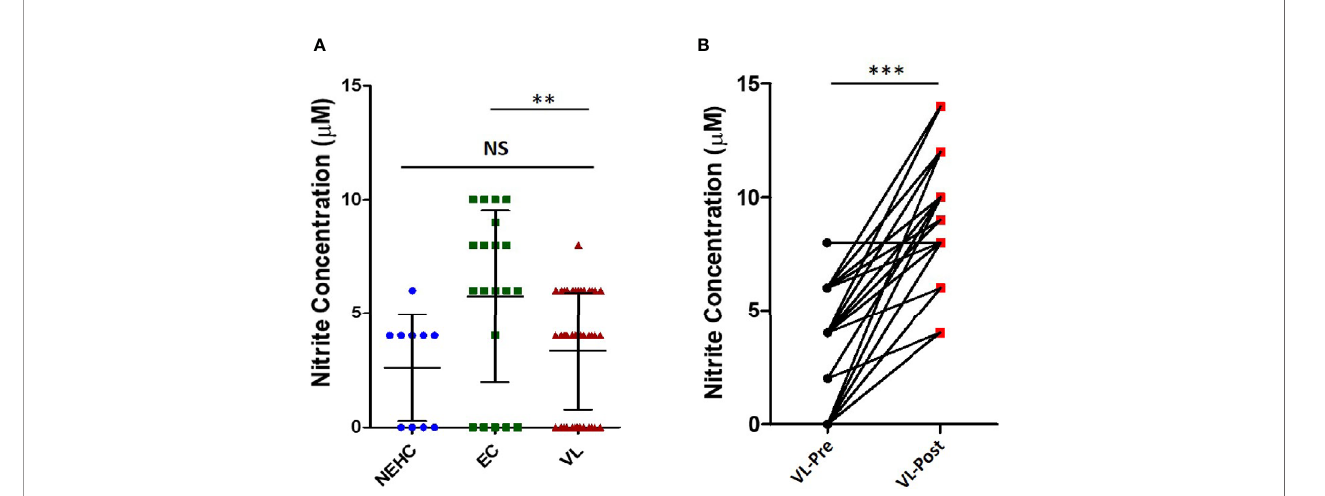
FIGURE 1 | Nitrite levels in the VL plasma show improvement upon treatment. (A) Nitrite concentration in the plasma from VL patients (n=45) (circles), ECs (n=25) (squares), and NEHCs (n=10) (triangles) was determined by Griess ’ assay. A two-tailed Mann-Whitney test was performed to compare the statistical differences between groups. (B) Same as in panel A, but a before and after plot for paired VL plasma samples (n=38), i.e., VL patients at presentation (circles) and after completion of treatment (squares). Wilcoxon signed rank test was applied for statistical signi fi cance. The data were earlier con fi rmed for Gaussian distribution (D ’ Agostino and Pearson omnibus normality test). **p < 0.01, ***p < 0.001; NS, not signi fi cant; VL, visceral leishmaniasis; EC, endemic control; NEHC, non-endemic healthy